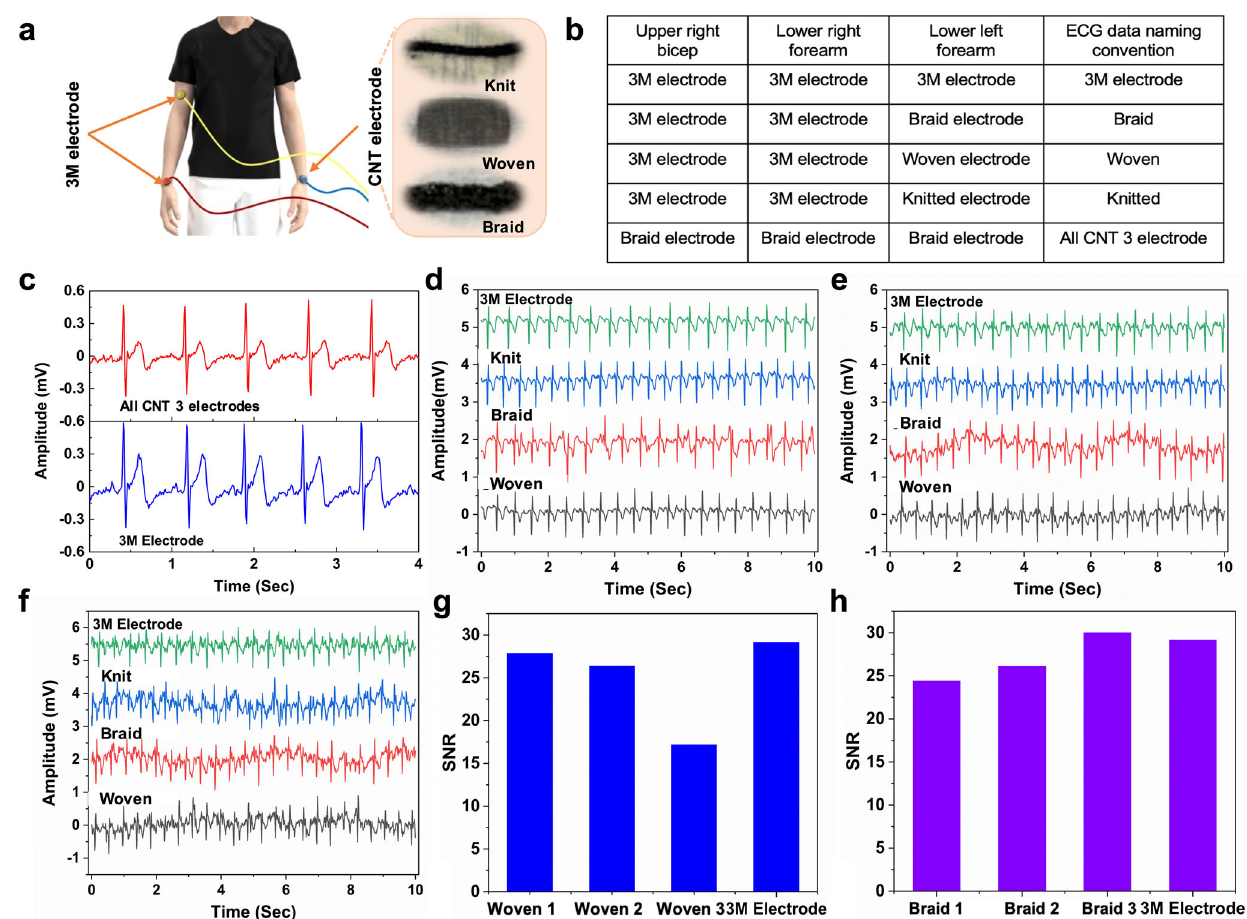
Fig. 4 Electrocardiogram Sensing Performance of CNT Textile Electrodes. a Electrode placement for ECG recording b variation of lead positions and naming convention c ECG signal comparison between all carbon electrode (three braided electrodes were used-top) and commercial 3M wet electrode (bottom) ECG signal comparison from walking to running movements with d 2 mph e 4 mph and f 6 mph of movement speed. Comparison of SNR at static condition against different electrode sizes g woven electrodes h braided